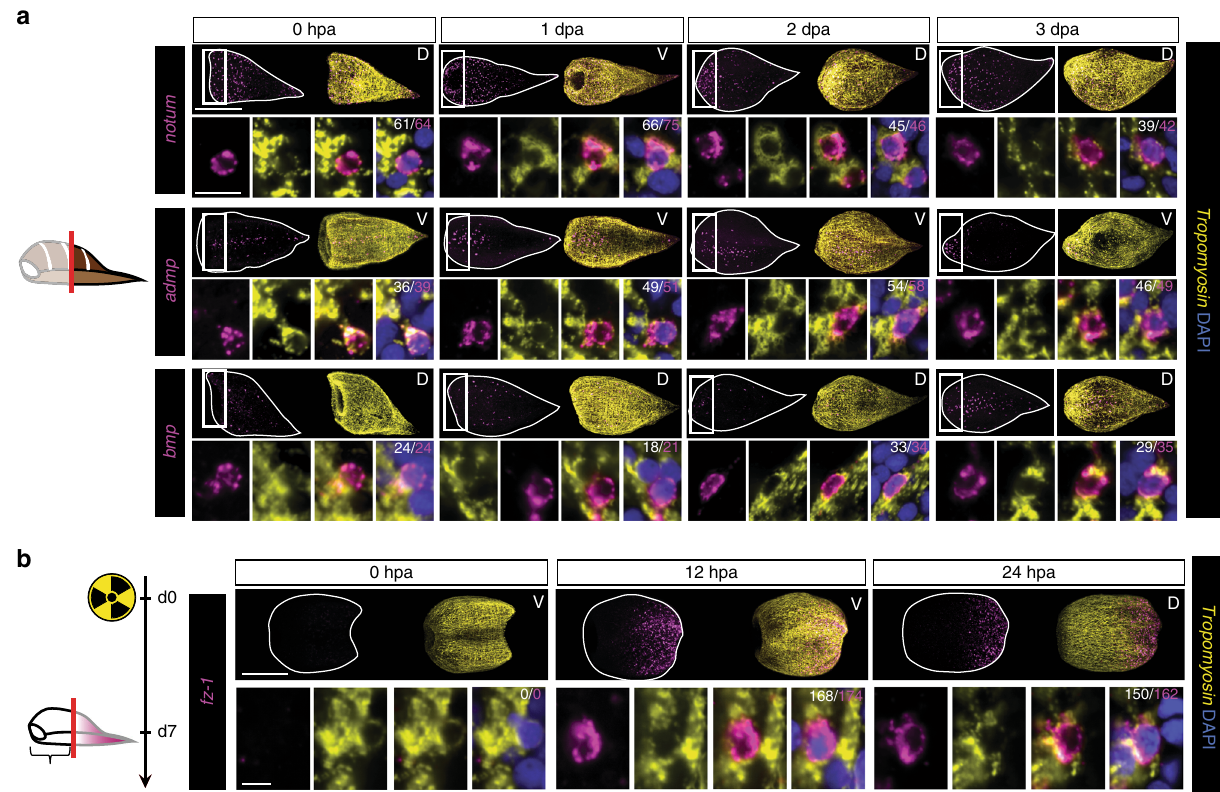
Fig. 5 Muscle cells dynamically re-express PCGs during regeneration. a Animals underwent decapitation and the fraction of PCG-positive cells that expressed tropomyosin was assayed during blastema formation at 0, 1, 2, and 3 days post-amputation (dpa). The denominator for each quanti fi cation is the total number of PCG-positive cells; the numerator is the total number of PCG/ tropomyosin double-positive cells. Quanti fi cation was performed in area indicated by the white box, and inset panels below are higher magni fi cation images of cells for this region. b Animals were lethally irradiated with 10,000 rads and amputated after ablation of piwi-1 expression (7 days post-irradiation). PCG expression was assayed 12 and 24 hpa. The denominator for each quanti fi cation is the total number of PCG-positive cells; the numerator is the total number of PCG/ tropomyosin double-positive cells. Animals were from the same cohort as Supplementary Fig. 3b, c. Scale bars: a , b 100 μ m, overview image; 10 μ m, cell inset. D dorsal view, V ventral view. Overview images are representative of 5/5 animals